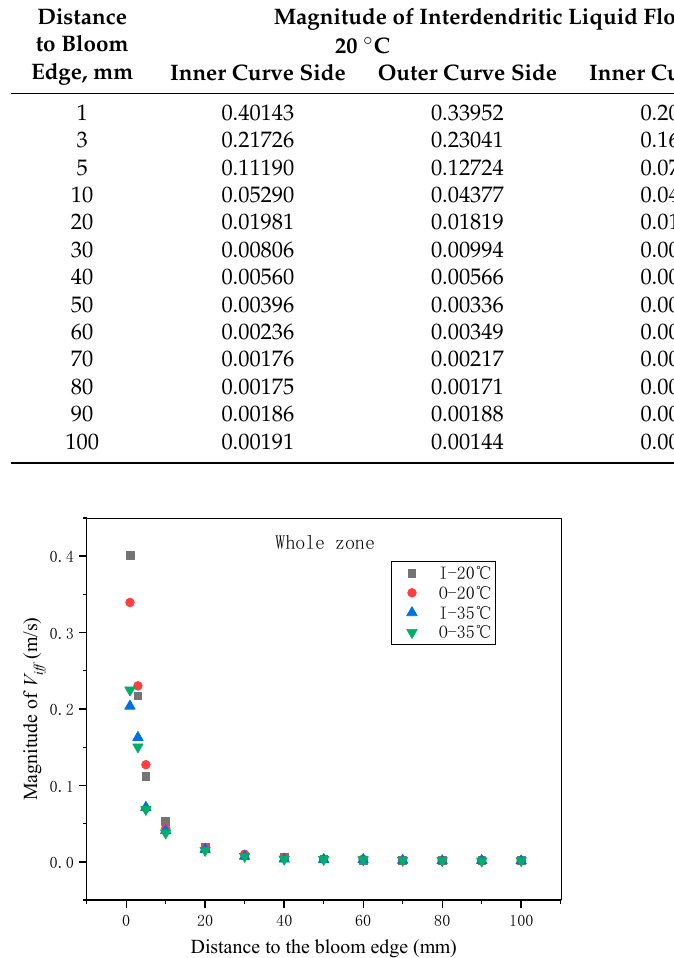
Figure 15. The magnitude of interdendritic fluid flow velocity V if f at different positions in the inner curve side (I) and outer curve side (O) of whole zone under 20 and 35 °C.